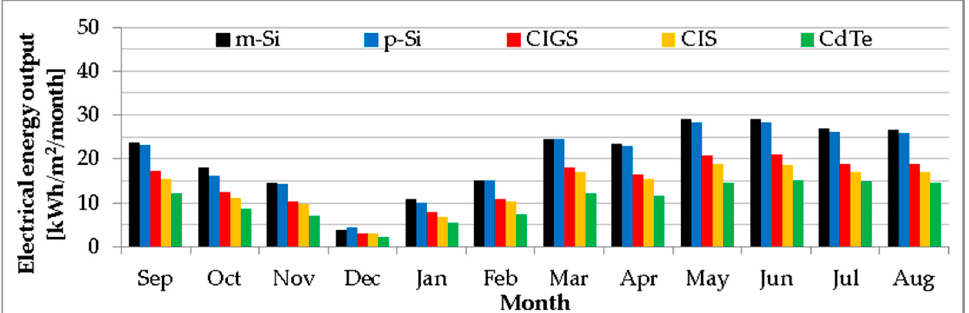
Figure 19. The monthly electrical energy output of the fixed photovoltaic modules.